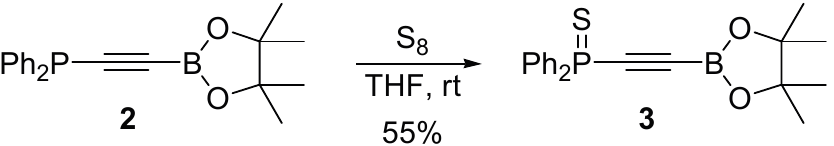
Figure 3. ORTEP diagram of alkyne 3 . H-atoms have been omitted for